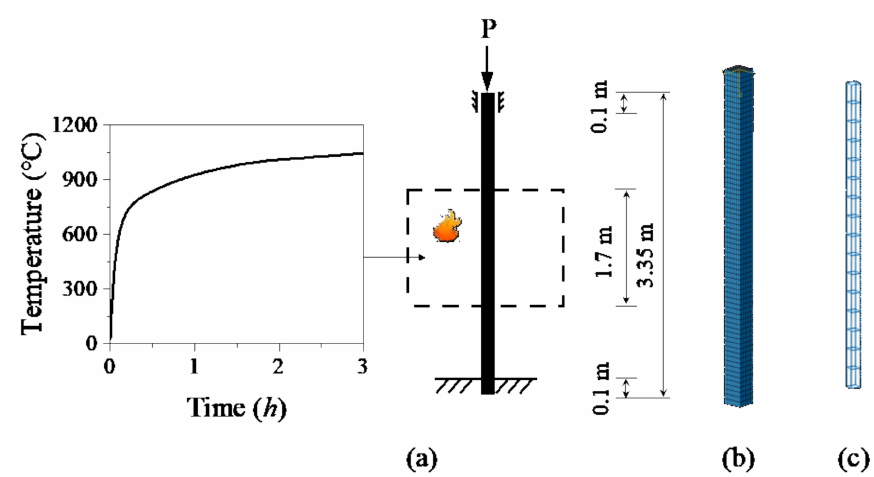
Figure 2. Numerical model details: ( a ) boundary conditions and temperature rise curve; ( b ) concrete mesh; and ( c ) reinforcing steel